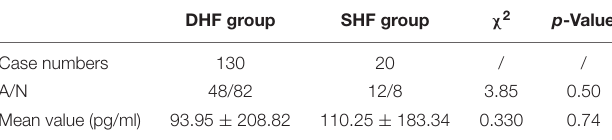
TABLE 4 | Plasma BNP levels in DHF and SHF patients. TABLE 6 | Case numbers of diastolic function indicators in DHF patients, before and after treatment.